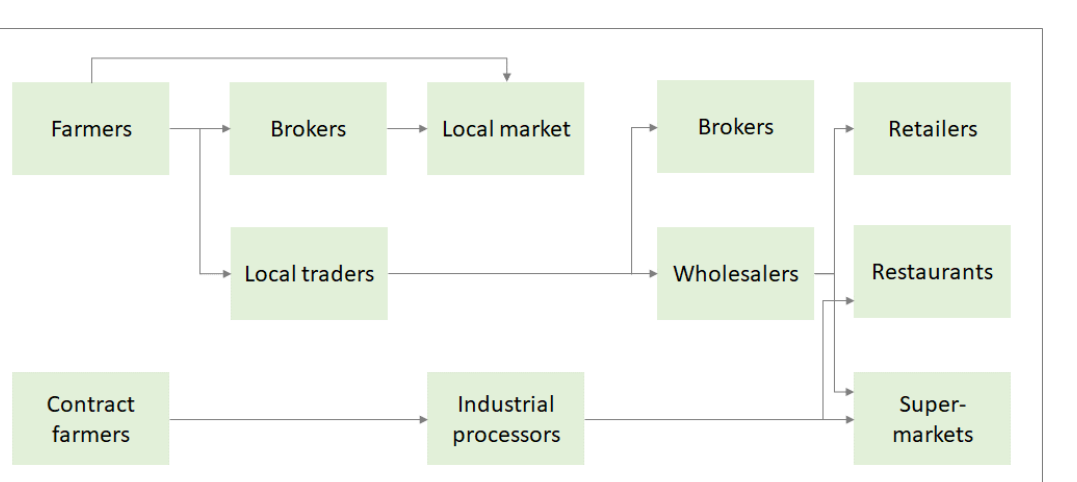
Table 1. Ware Potato Production in Metric Tons in Kenya per County (2016).